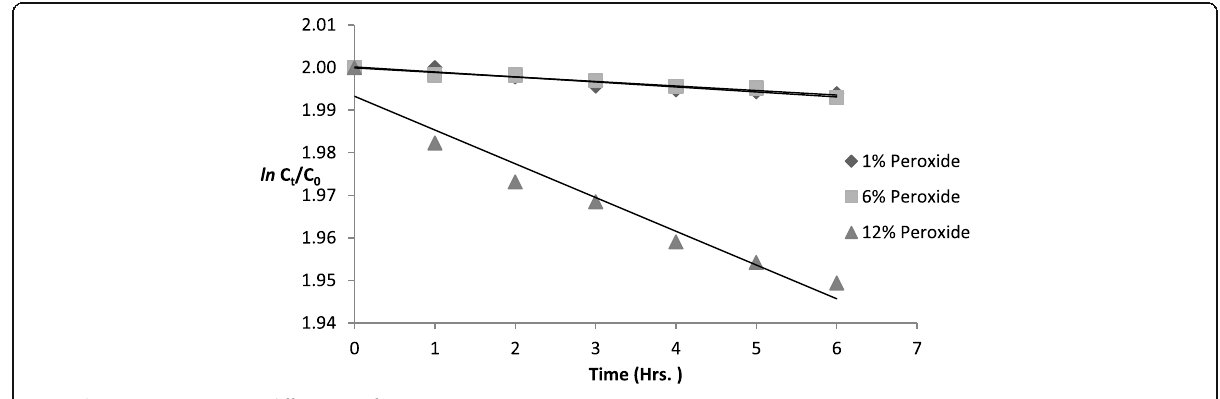
Fig. 4 ln C t /C 0 versus time in different % of H 2 O